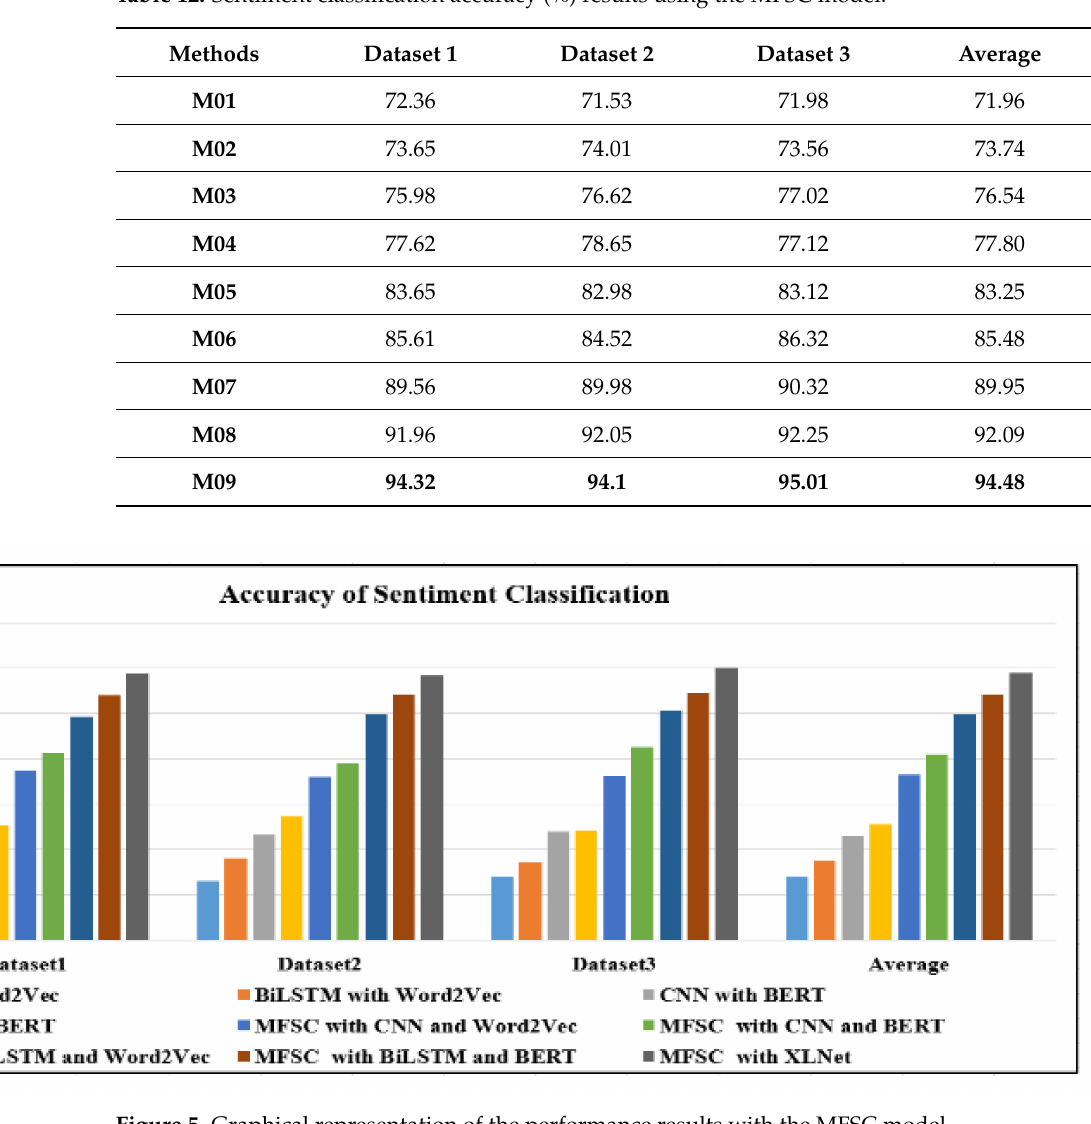
Figure 5. Graphical representation of the performance results with the MFSC